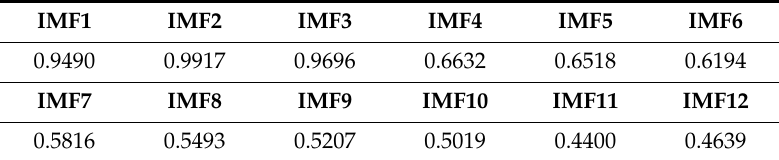
Figure 7. The decomposition result of MCEEMDAN. Table 3. The DEs of intrinsic mode functions (IMFs).